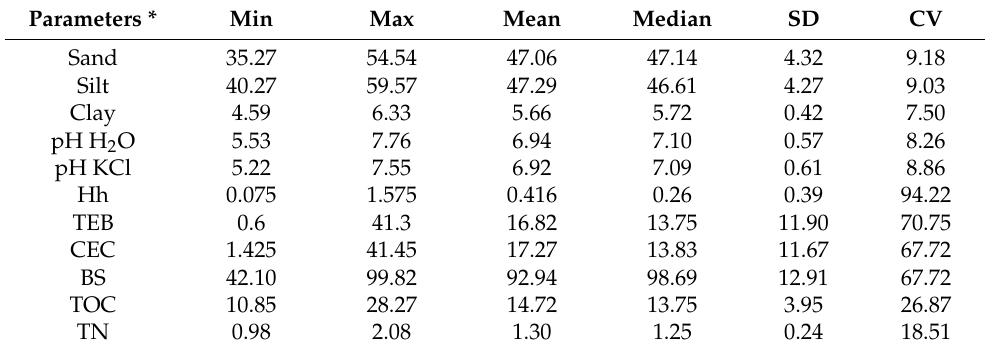
Table 1. Selected physical and chemical properties ( n =